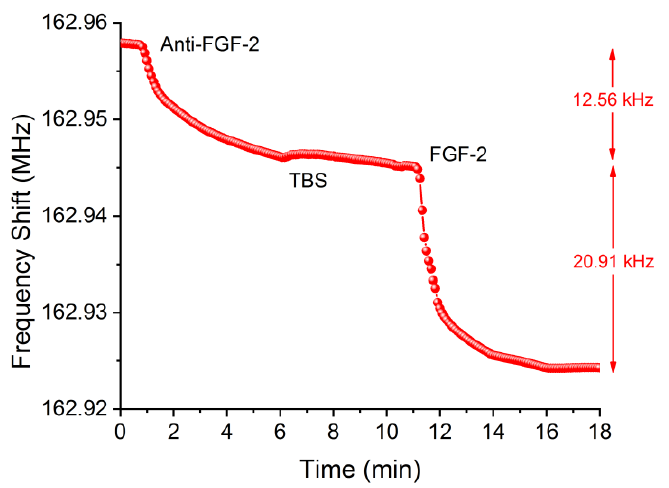
Figure 5. Complete sensing process for FGF-2 (25 μg/mL) without BSA.